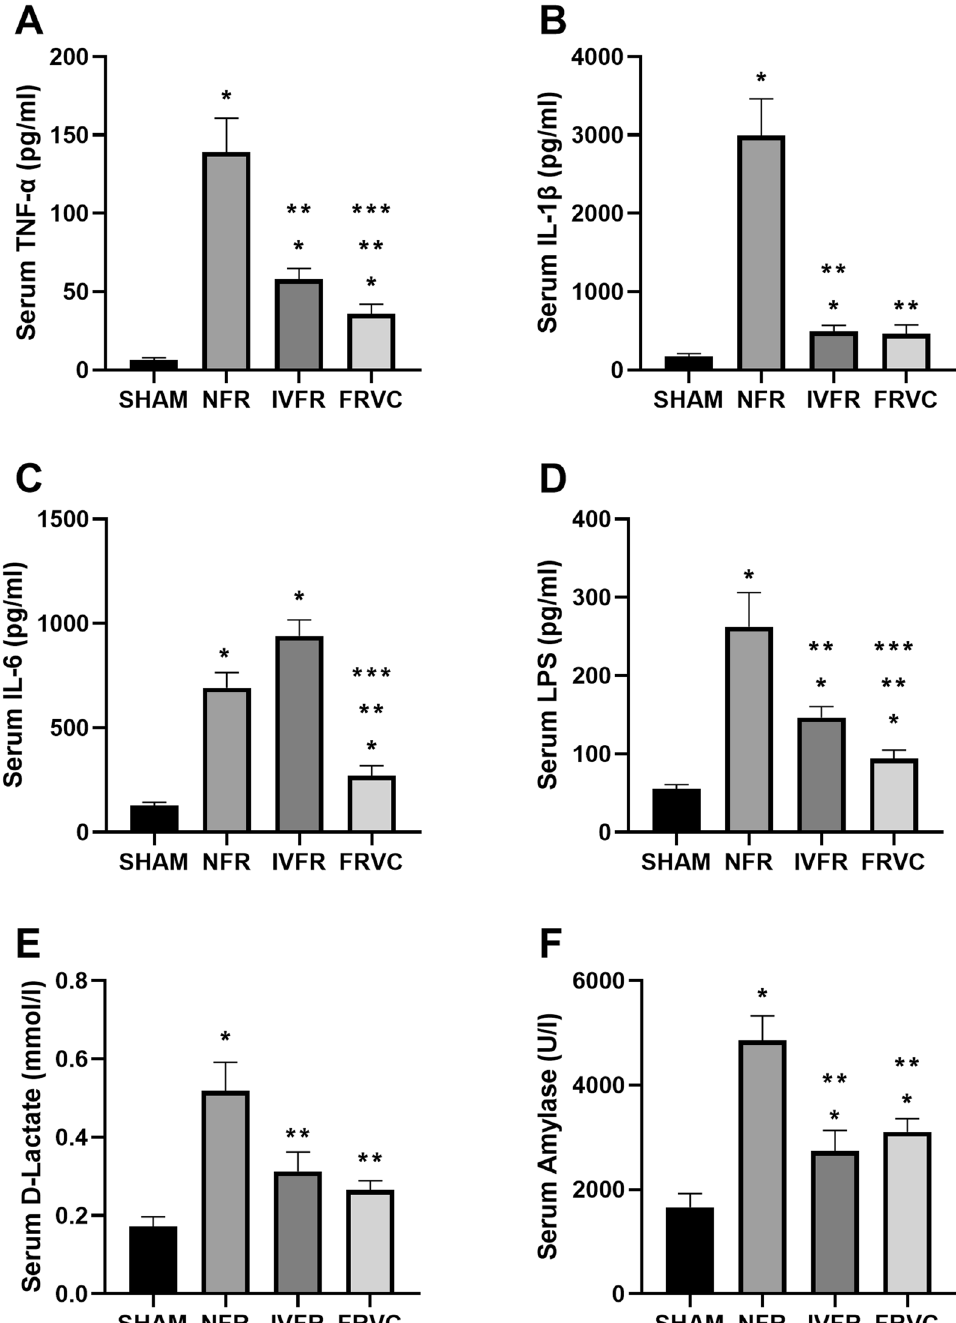
Figure 4. Changes in levels of systemic cytokines in SAP rats and SAP rats treated with IVFR or FRVC. ( A – F ) Serum levels of TNF-α, IL-1β, IL-6, LPS, D-lactate, and amylase were analyzed via ELISA. * p < 0.05 compared to SHAM, ** p < 0.05 compared to NFR; *** p < 0.05 compared to IVFR. SHAM: the rats treated with sham operation and no fluid resuscitation; NFR: the rats treated with the SAP operation and no fluid resuscitation; IVFR: the rats treated with the SAP operation and intravenous normal saline infusion; FRVC: the rats treated with the SAP operation and normal saline infusion via colon. TNF-α, tumor necrosis factor-α; IL-1β, interleukin-1β; IL-6, interleukin-6; LPS,